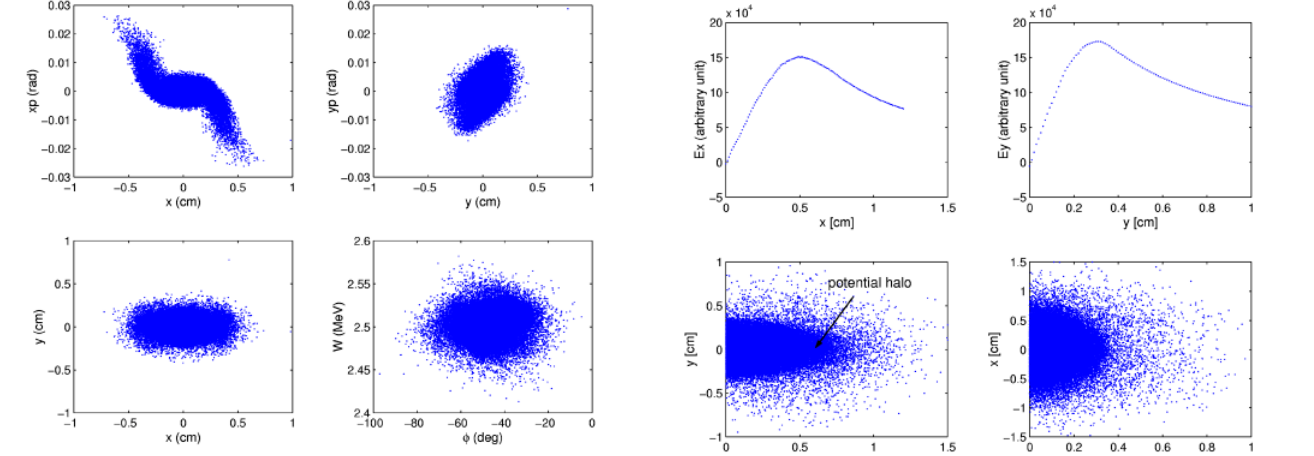
FIG. 3. (Color) Transverse and longitudinal phase-space projec- tions of the beam at the end of MEBT. On the contrary to the MEBT input beam, well-developed horizontal halo is observed. This is a result of the MEBT optics. The normalized x ( y ) rms emittance is 0.21 (0.20) p mm mrad.